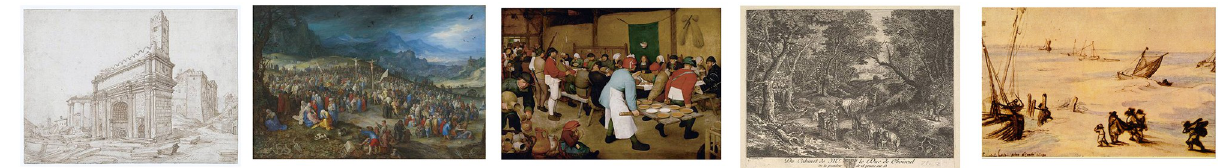
Fig 9. Examples of paintings in the Brueghel dataset. The depicted images show the diversity of artworks in the Brueghel dataset. It includes artworks of various subject matters (i.e. landscapes, genre paintings), in different techniques (i.e. drawing, oil, print) and materials (i.e. paper, canvas). Due to copyright issues, we exchanged several images. We made sure that replacements are as similar as possible to the originals. The image material is shared by Wikimedia Commons [5] as public domain.